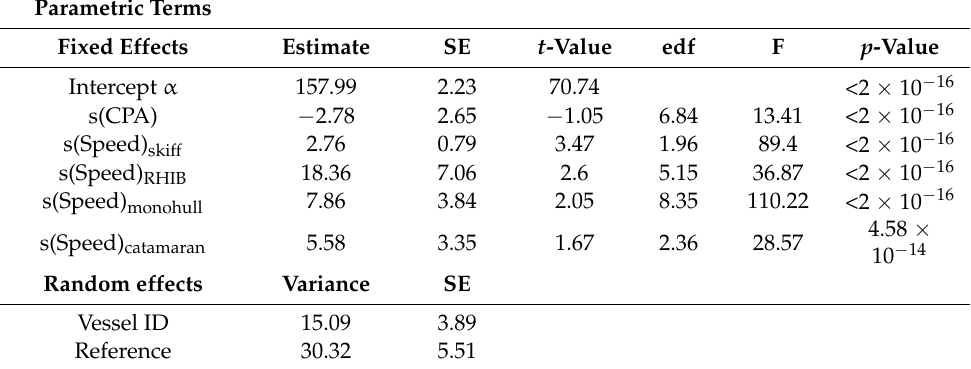
Table 5. Results of the final GAMM. s() presents the details of the estimated smoother for each vessel type. Estimates for the intercept α and each smoothing term are given, as well as the standard error (SE), estimated degrees of freedom (edf), and approximate significance of the smooth terms as the t -value, F-statistics (F), and p -value. The variance and standard error (SE) are given for the random effects in the